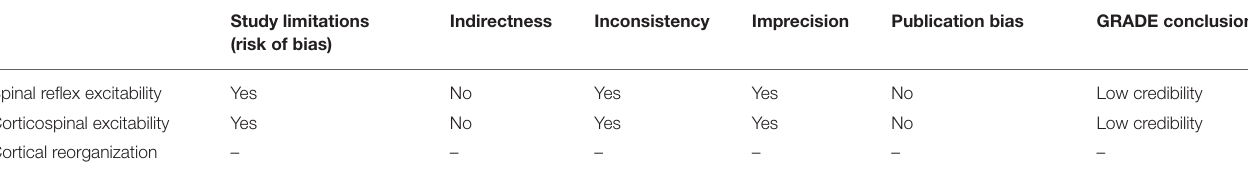
TABLE 4 | GRADE (Grading of Recommendations Assessment, Development and Evaluation) rating.